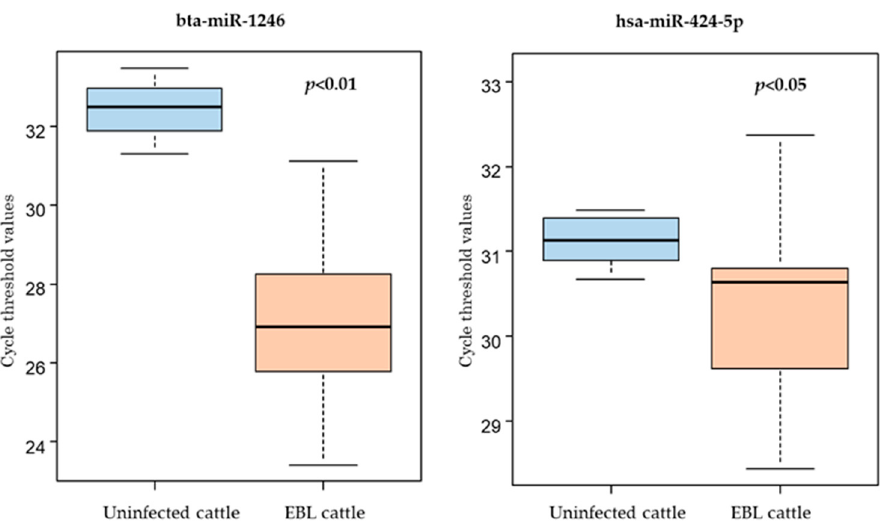
Figure 4. Evaluation of the utility of bta-miR-1246 and hsa-miR-424-5p as biomarkers using freshly collected milk small extracellular vesicles (sEVs) from seven uninfected and 13 enzootic bovine leukosis (EBL) cattle employing qPCR. The levels of bta-miR-1246 and hsa-miR-424-5p were significantly higher in milk sEVs from EBL cattle ( n = 13) than in those from uninfected cattle ( n = 7). Mean of cycle threshold values is shown as a horizontal bar in the boxes.